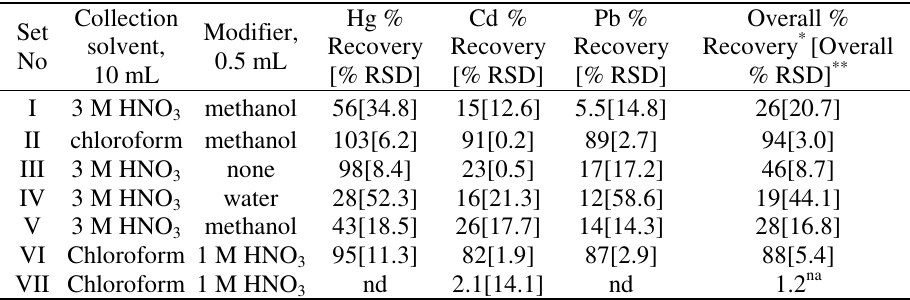
Table 2. Optimization results at different SFE conditions showing the mean percent recoveries of Hg, Cd and Pb from the SFE of CRM (NCSDC 73372) using cyanex as chelating agent